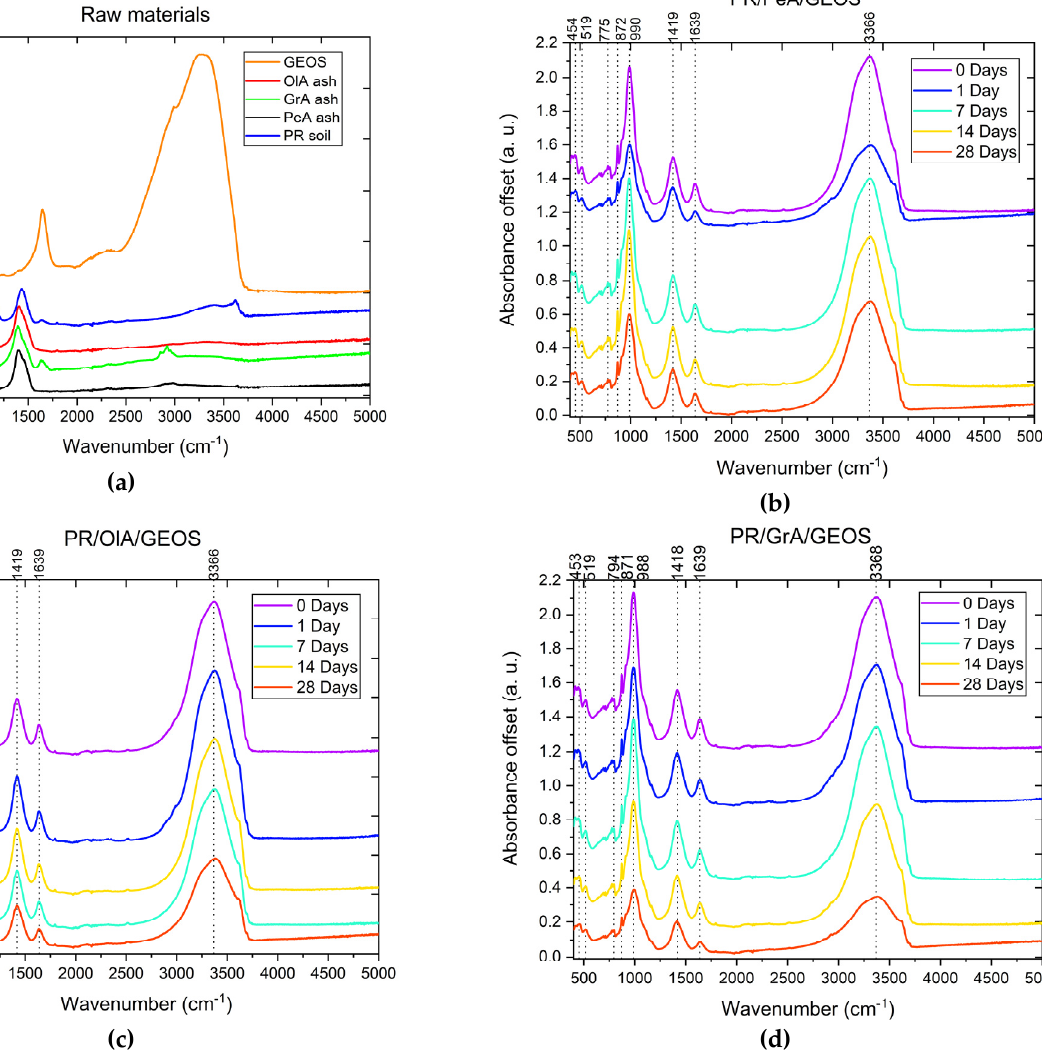
Figure 10. FR-IR spectra of raw materials used in this work and clayey soil mixtures after 60 days of curing. ( a ) FT-IR spectra of raw biomass ash, clayey soil, and liquid activator. FT-IR spectra of PR/PeA/GEOS ( b ), PR/OlA/GEOS ( c ), and PR/GrA/GEOS ( d ) soils at different curing times. The positions of the bands shown in the figures and marked with dotted lines refer to a curing time of 0 days. In each graph, absorbance is reported in arbitrary units (a.u.). Spectra are offset for clarity.